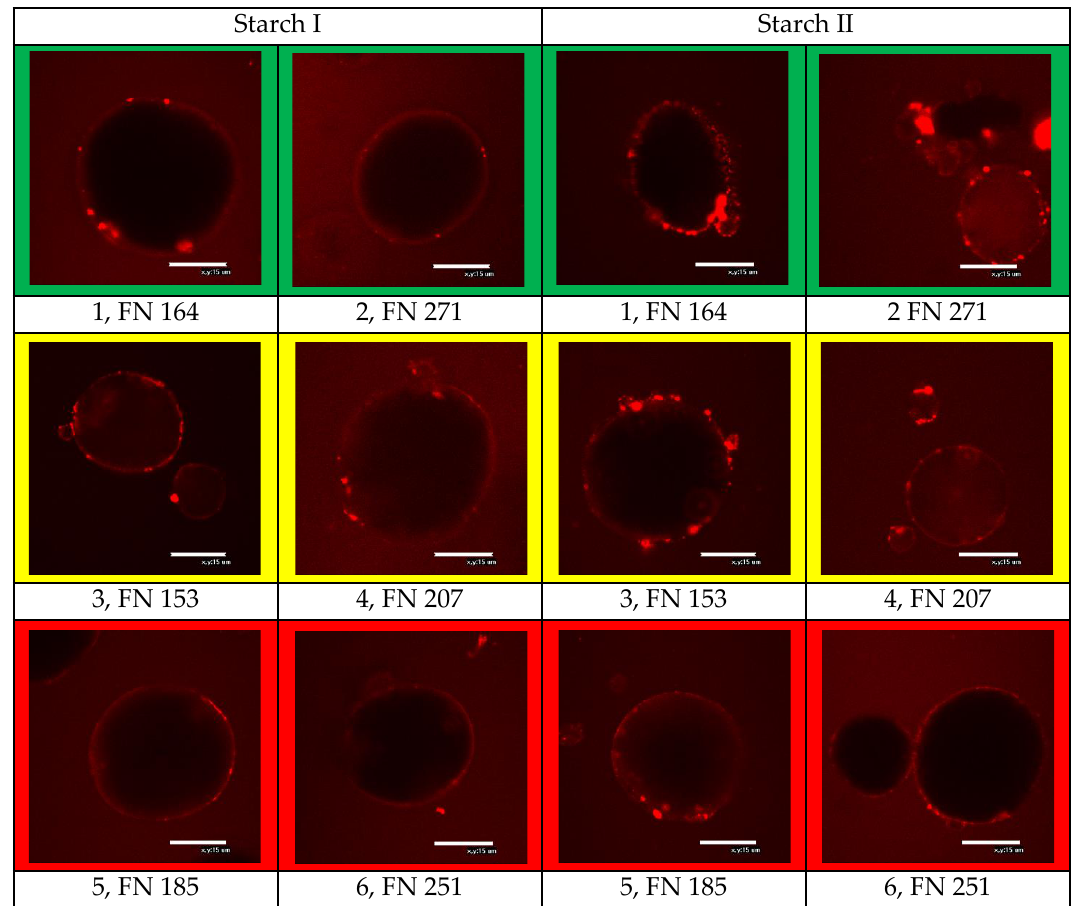
Figure 6. Microscopic images of protein distribution and coating (red spots and aura) of the starch granules (black balls) surfaces of the selected samples, depending on “good” to “medium” to “poor” baking quality and the corresponding falling number (FN) within the individual baking quality classes (here: first samples were always assigned the lower FN and second samples the higher FN). Sample description: see Table 1; bar = 15 µ